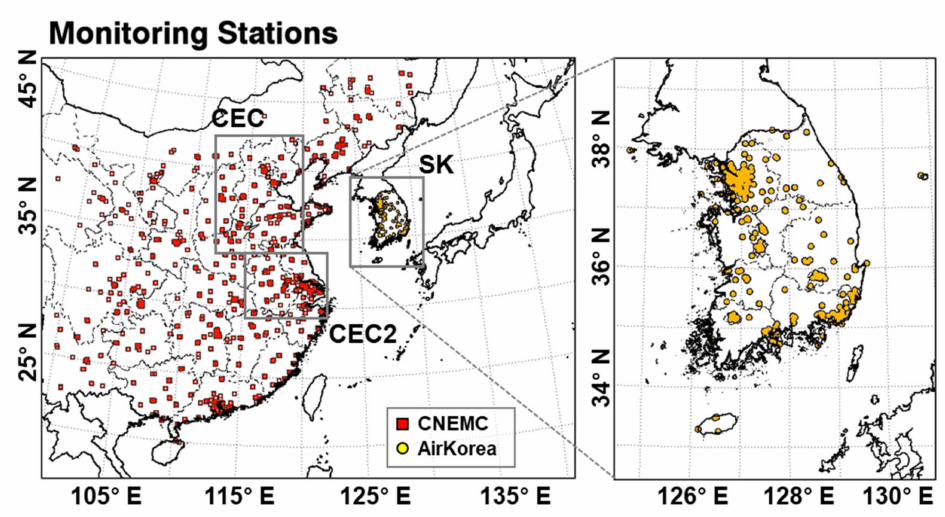
Figure 4. Analysis regions of CEC, CEC2, and SK. Monitoring stations of CNEMC (closed red squares) and AirKorea (closed yellow circles) utilized for the